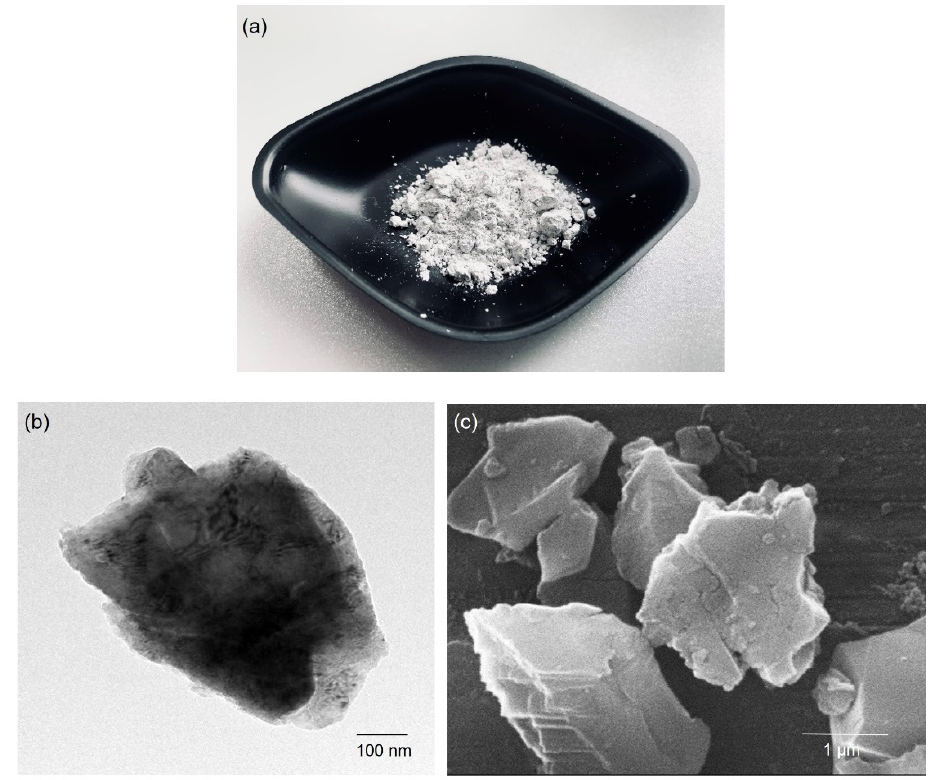
Figure 1. ( a ) Macroscopic view of the raw corundum powder, ( b ) TEM micrograph, and ( c ) ESEM micrograph showing purified particles with an irregular shape but a smooth, nonporous surface.